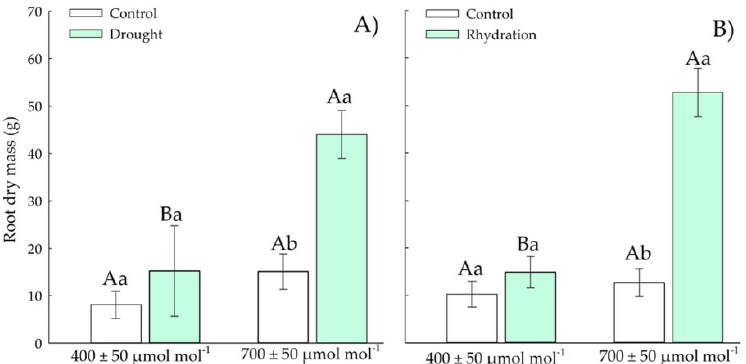
Figure 6. Effects of CO 2 concentration ( a [CO 2 ] = 400 µmol mol − 1 and e [CO 2 ] = 700 µmol mol − 1 ) and drought stress in A. buniifolius in root dry mass. In plants sampled after drought stress ( A ) and rehydration ( B ) period. Different uppercase letters indicate a significant difference between values in different CO 2 within the same water treatment, while different lowercase letters indicate signifi- cant differences between values of different water treatments within each CO 2 level by Tukey’s test ( p ≤ 0.05). ns denotes non-significance ( p > 0.05). Error bars represent a 95% confidence interval.